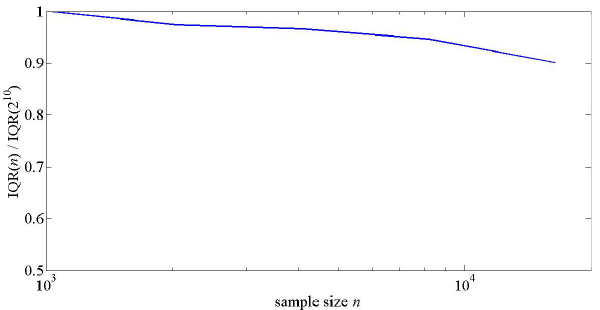
Fig. 7. Semi-logarithmic plot of the interquartile range (IQR) (stan- dardized with respect to the IQR for n = 2 10 ) of the prediction in- tervals for the third moment versus the sample size n for the log- normal series generated by our downscaling model (Lombardo et al.,